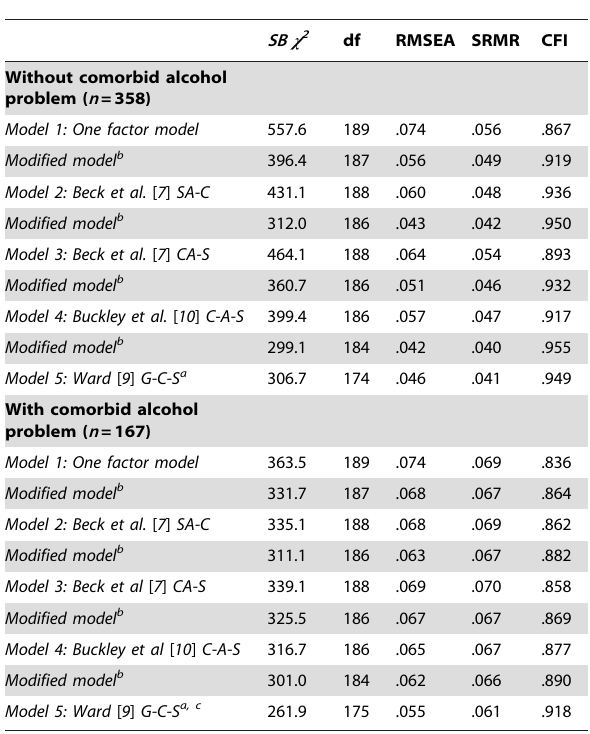
Table 2. Confirmatory factor analysis fit indices for five different factor models. Separately for the samples with and without comorbid alcohol problems.